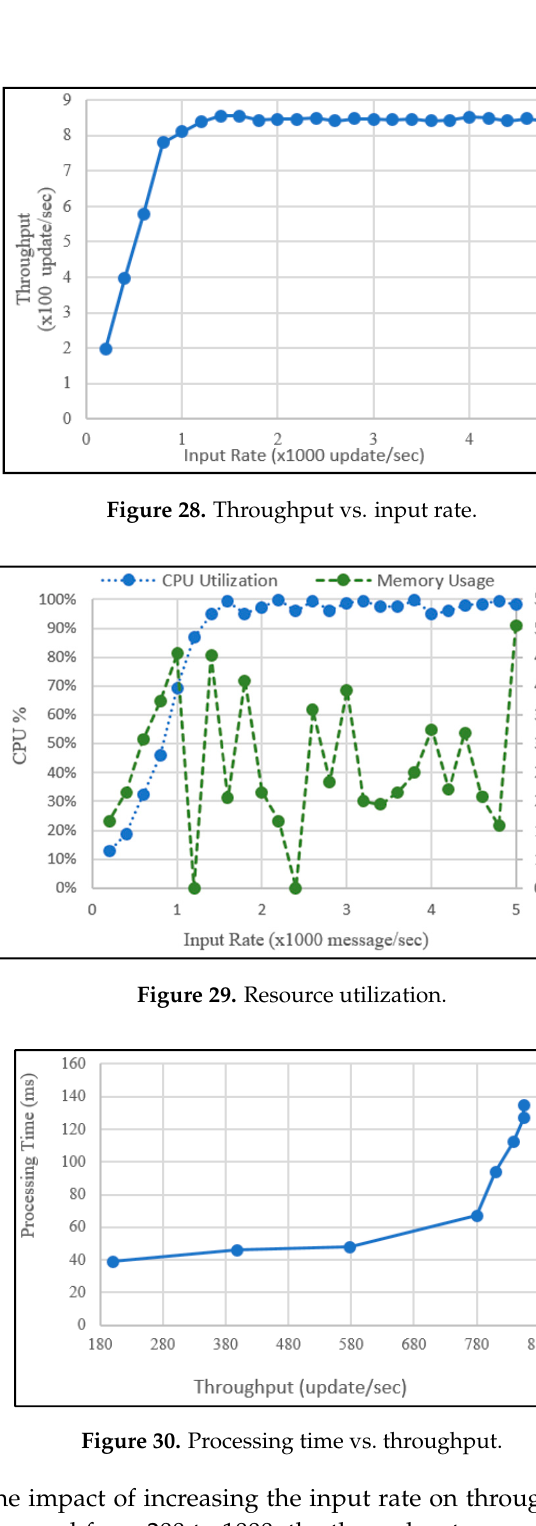
Figure 29. Resource utilization. Figure 31. Processing time vs. number of subscriptions.